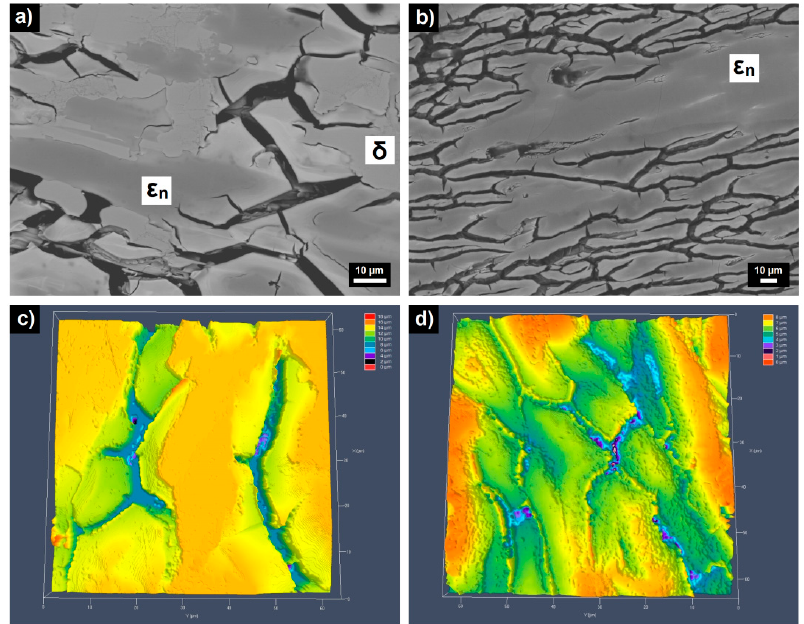
Figure 10. BEI / SEM images ( a , b ) and CLSM images ( c , d ) of as-polarized Al 70 Pd 25 Co 5 ( a , c ) and Al 74 Pd 12 Co 14 ( b , d ) alloys. Phases assigned to particular constituents are also marked. For the color interpretation of this figure, the reader is referred to the web version of this article. A dissolution of Al in the Al 70 Pd 25 Co 5 alloy has been found (Table 4). Simultaneously, the Al concentration in ε n decreased from 72.5 to 69.0 at.% (Table 4). In the Al 74 Pd 12 Co 14 alloy, a decrease of Al concentration in ε n from 73.9 to 71.1 at.% has been found. Thus, the level of Al de-alloying was higher in the double phase Al 70 Pd 25 Co 5 alloy. Moreover, the pits found in this alloy were deeper compared to the Al 74 Pd 12 Co 14 alloy. The formation of cracks observed in the as-polarized alloys could be governed by a combination of de-alloying kinetics and the release rate of internal stresses. As the electrochemical potential is raised in a positive direction, the dissolution rate of the alloy increases (Figure 8). This electrochemical force drives the surface at the de-alloying front further away from the equilibrium [37]. The removal of Al from the alloy phases leads to microcrack initiation. The residual stress accumulated in the alloys during rapid solidification is released during de-alloying. Corrosion potentials and corrosion current densities of the as-solidified Al–Co [17,18,20,21,38], Al–Pd [24], and Al–Pd–Co alloys are compared in Figure 11. The corrosion potentials of the Al–Co alloys show a significant dependence on the Al atomic fraction. They become more negative with increasing Al concentration. The corrosion potentials of the Al–Pd alloys, on the other hand, are relatively constant with respect to the alloy’s overall chemical composition. They are, in fact, more negative than the corrosion potentials of the remaining two groups of alloys. The corrosion currents of the Al–Pd alloys, on the other hand, are higher compared to the Al–Co and Al–Pd–Co alloys (Figure 11b). These observations suggest that the Al–Pd alloys are less corrosion-resistant compared to both the Al–Pd–Co and Al–Co alloys. The corrosion behavior of the Al–Pd–Co alloys is closer to the behavior of the Al–Co alloys. This observation is unexpected, since both alloy groups have a different chemical composition and phase constitution. Moreover, ε n , the preferentially corroding phase in the Al–Pd–Co alloys, is not present in the Al–Co alloys. Therefore, it can be suggested that Al 3 Co SCIPs are nobler compared to binary ε n (Al 3 Pd). This is manifested by the less negative corrosion potentials of the Al–Co alloys compared to the Al–Pd alloys with a similar Al atomic fraction (Figure 11). Furthermore, the Co substitution for Pd significantly improves the corrosion